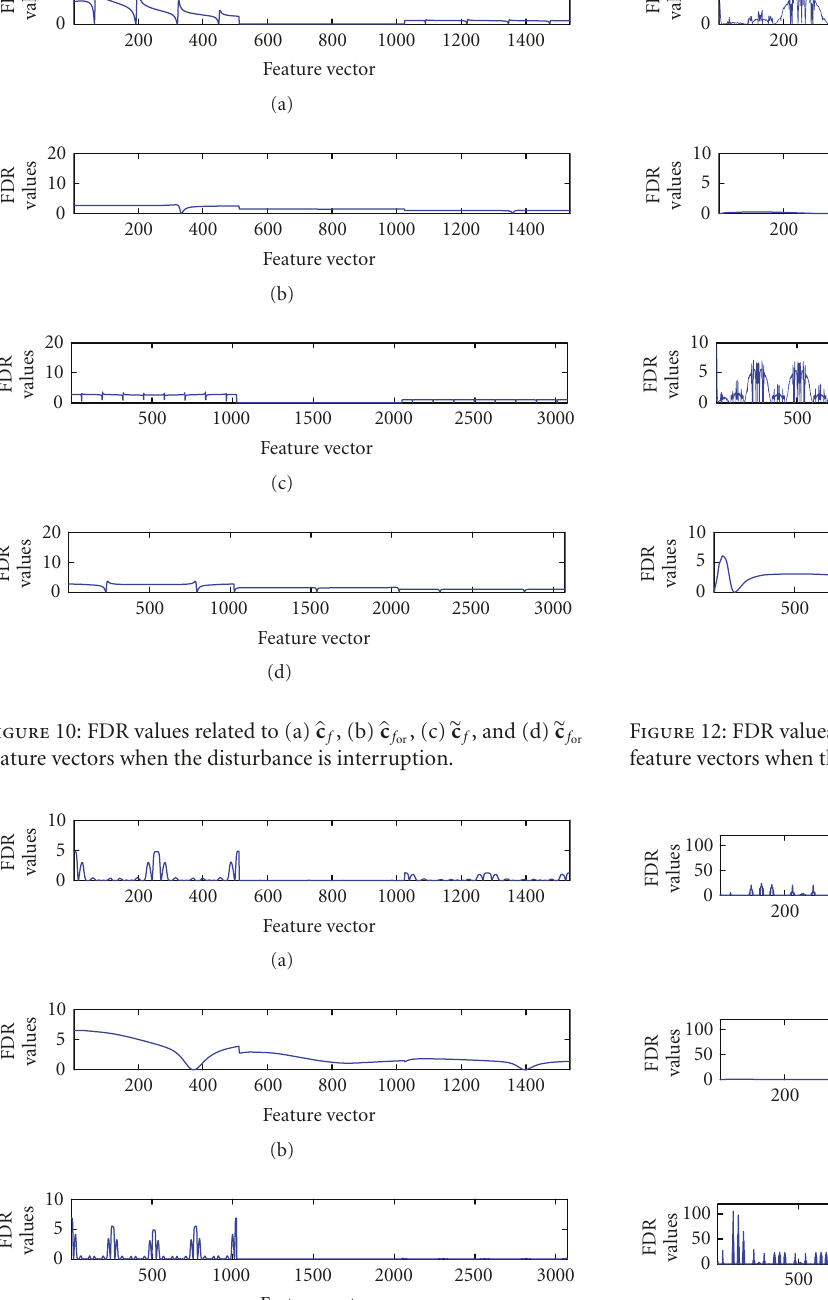
, (c) (cid:21) c u , and (d) (cid:21) c u or or